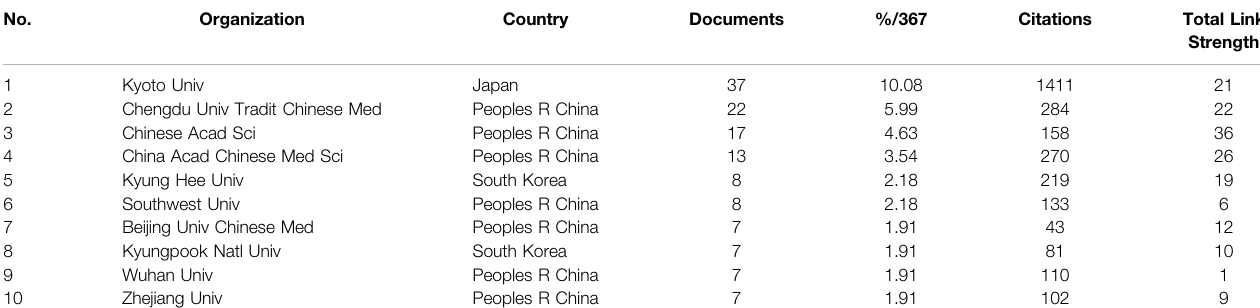
TABLE 3 | The top 10 institutions in Coptis